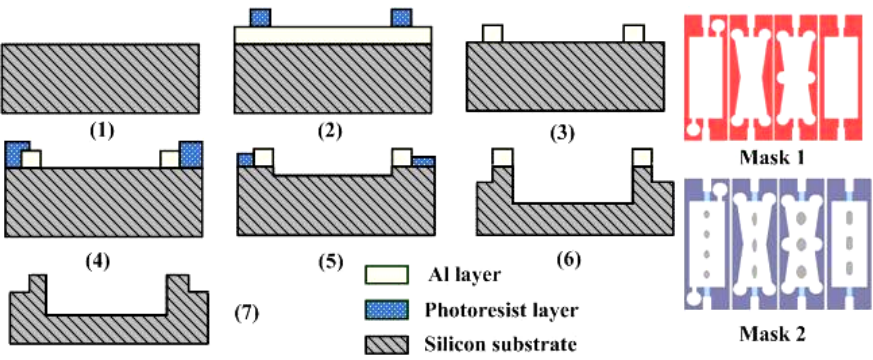
Figure 2. Fabrication process sequence and the mask